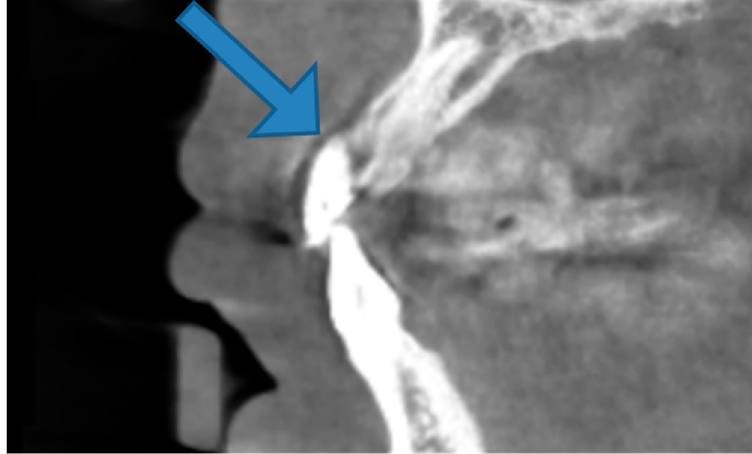
Figure 2. Determination of gingival thickness in CBCT (arrow).